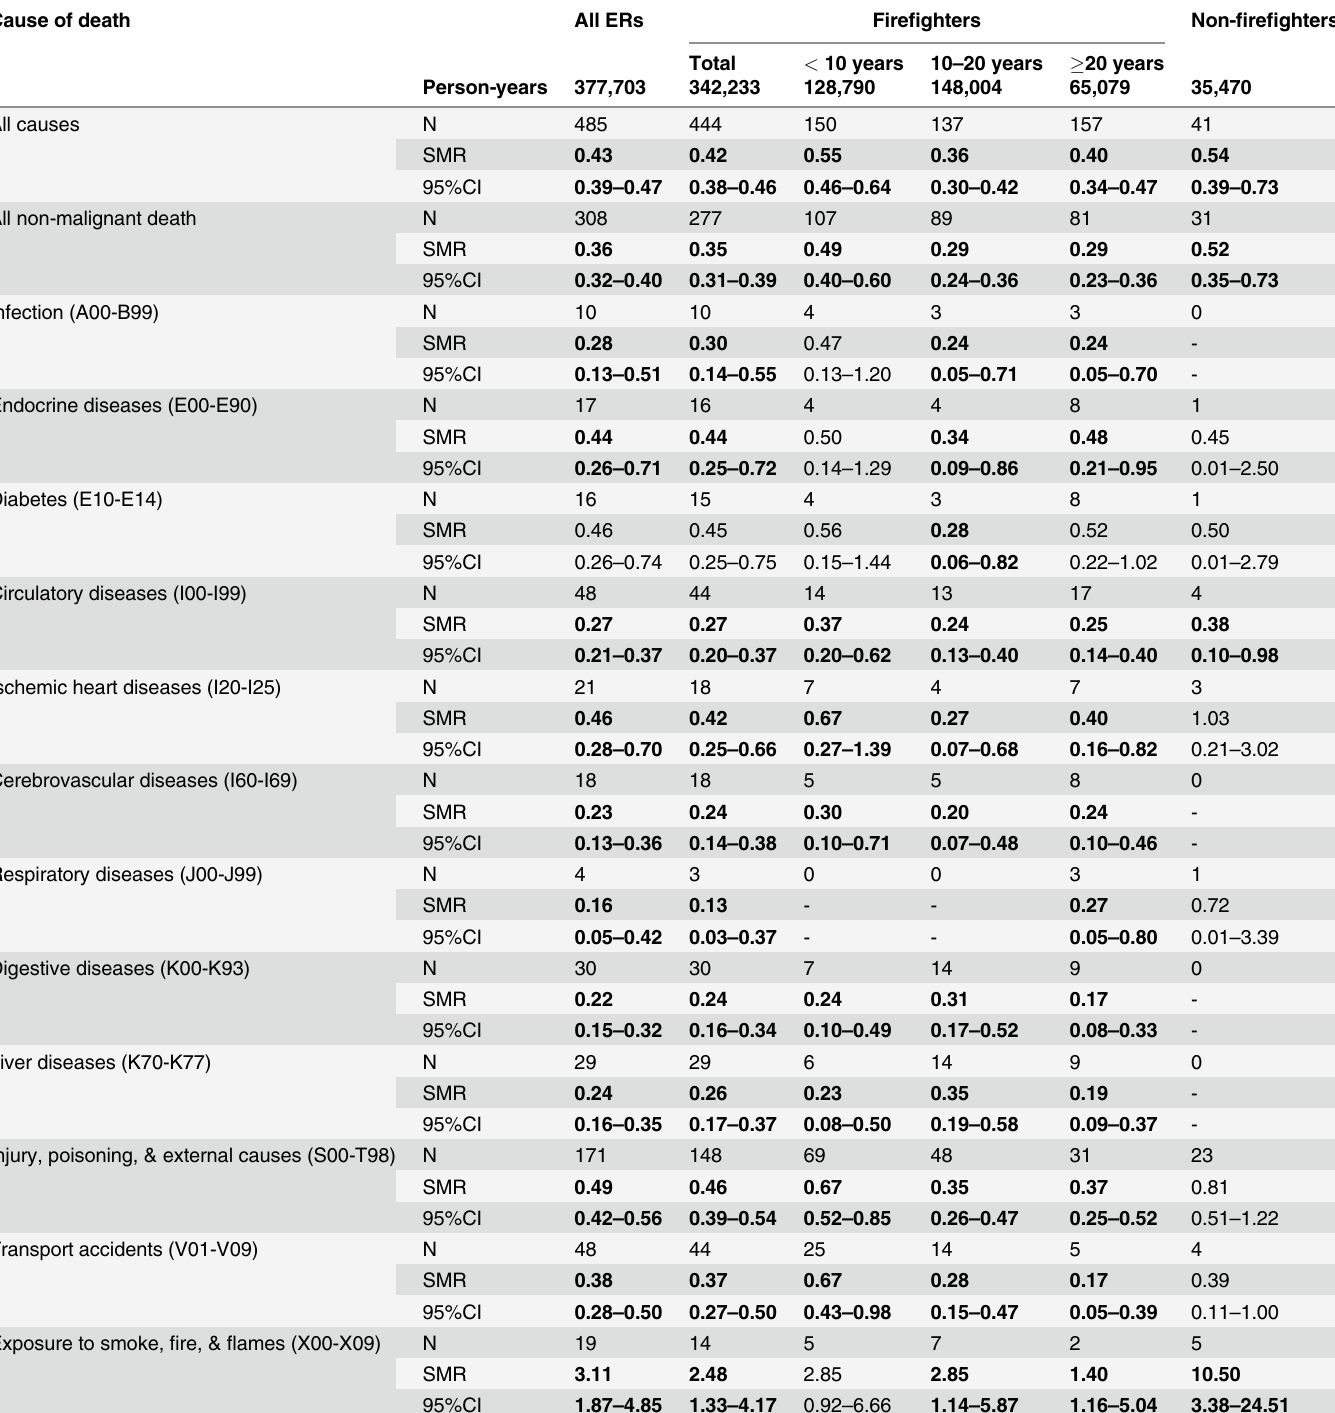
Table 2. Mortality (SMR) due to non-malignant disease in emergency responders (ERs) (Reference: Korean